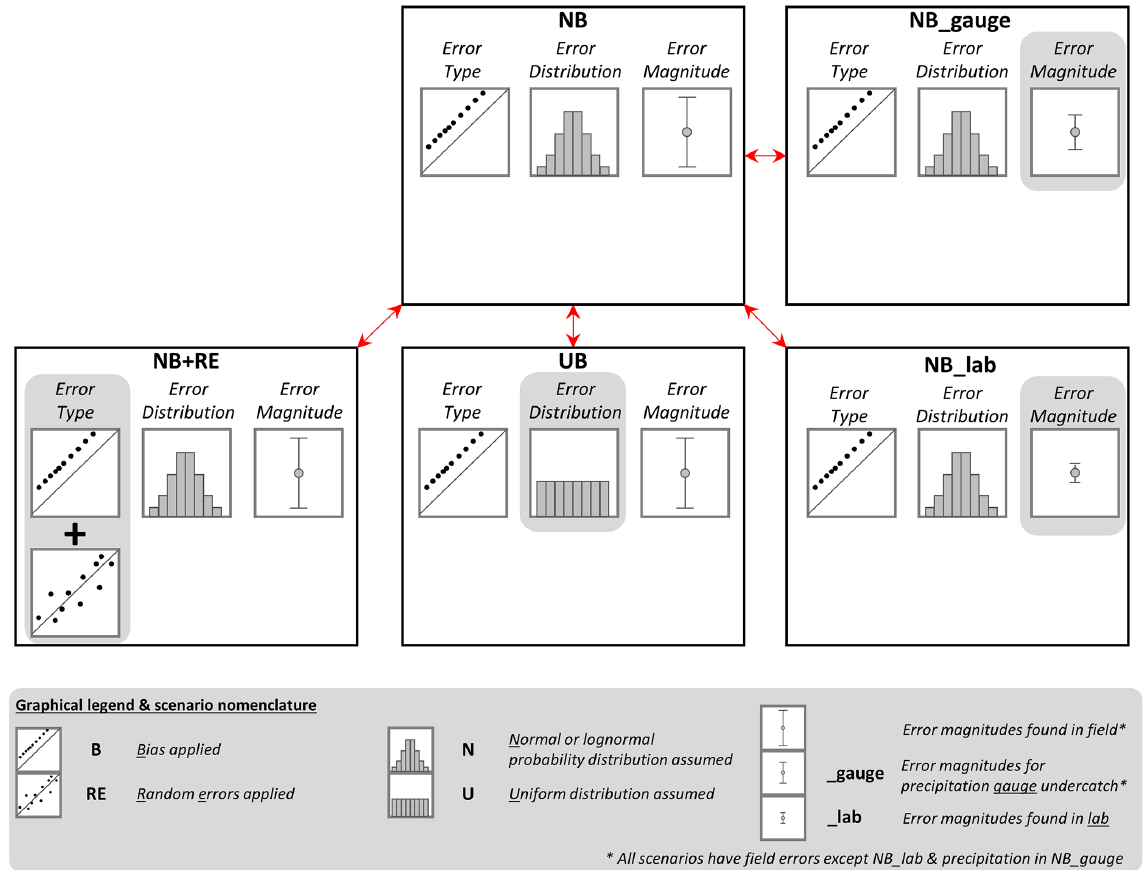
Figure 1. Scenarios of interest and the type, distribution, and magnitude of errors considered in each. NB considers normally (or lognormally) distributed biases with error magnitudes found in the field. NB + RE is the same as NB but also considers random errors. UB is the same as NB but considers uniformly distributed errors instead. NB_gauge is the same as NB but with reduced precipitation uncertainty (typical difference between precipitation gauge and snow pillow). NB_lab is the same as NB but considers laboratory error